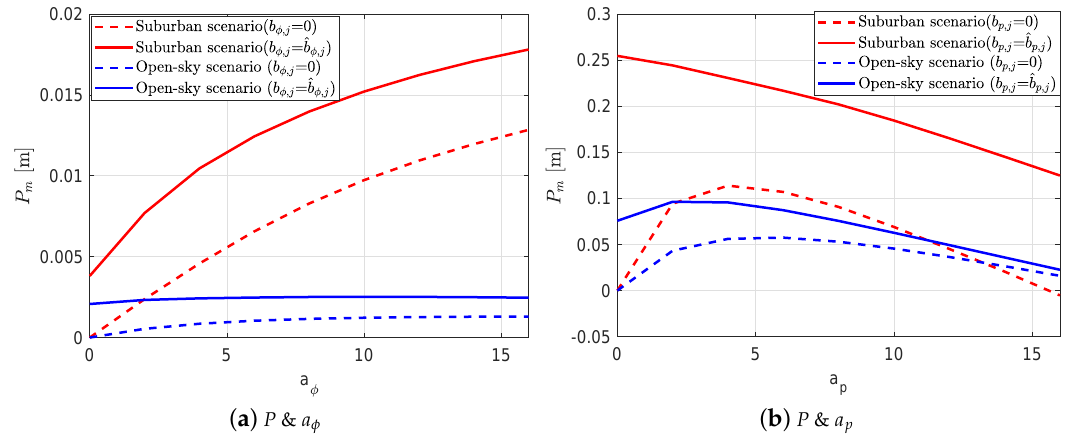
Figure 4. Improvement P m in ( a ) phase-based and ( b ) code-based positional results with respect to the coefficients a φ and a p